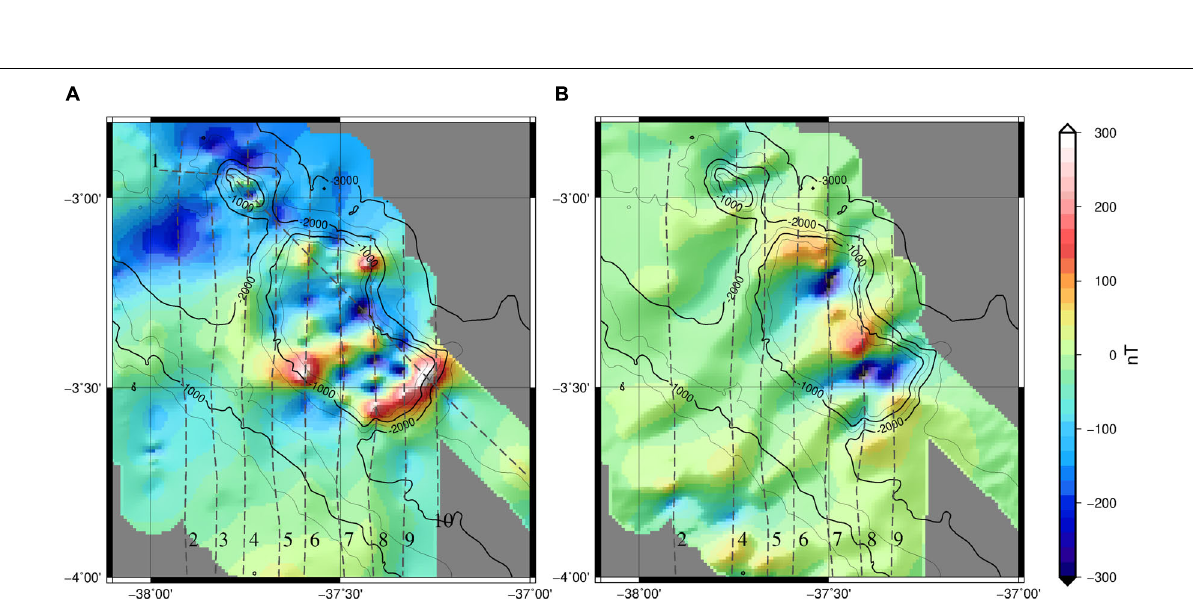
FIGURE 7 | Mohoroviˇci´c discontinuity of the Ceará Plateau area from the gravity 2D model. COB: Continental Ocean Boundary, TC: Transitional Crust.